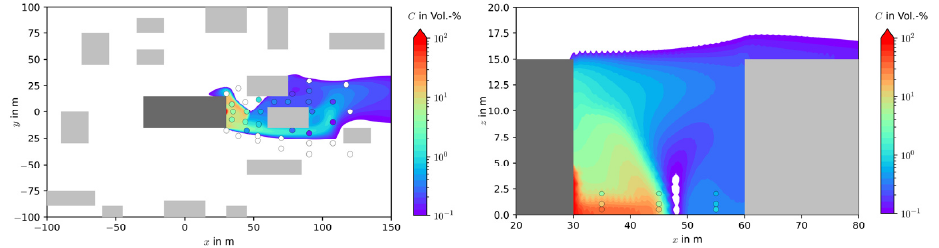
Figure 12. Heavy gas dispersion for case HG MR M1 S3, ( left ): top view with concentration isosurface in 2 m height over ground, ( right ): side view of a cut plane with concentration isosurface. Grey boxes representing buildings and the experimental measuring points represented by circles.